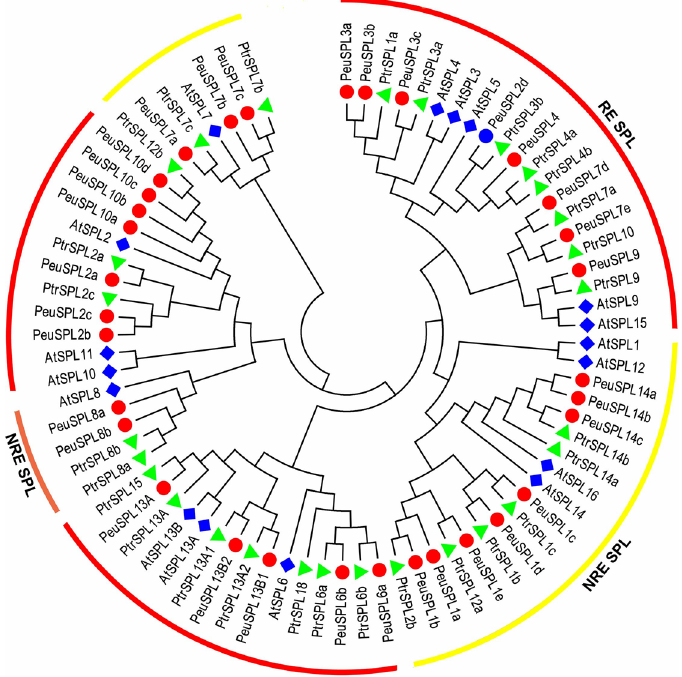
Figure 1. Phylogenetic analysis of SPL proteins in P. euphratica , P. trichocarpa , and Arabidopsis . The phylogenetic tree was built based on multiple sequence alignments of the SBP domain in the SPL proteins using the neighbor-joining method with 1000 bootstrap replicates. The red circles represent P. euphratica , and the diamonds and triangles represent Arabidopsis and P. trichocarpa , respectively . This figure was generated by MEGA 7 (https:// www. megas oftwa re.